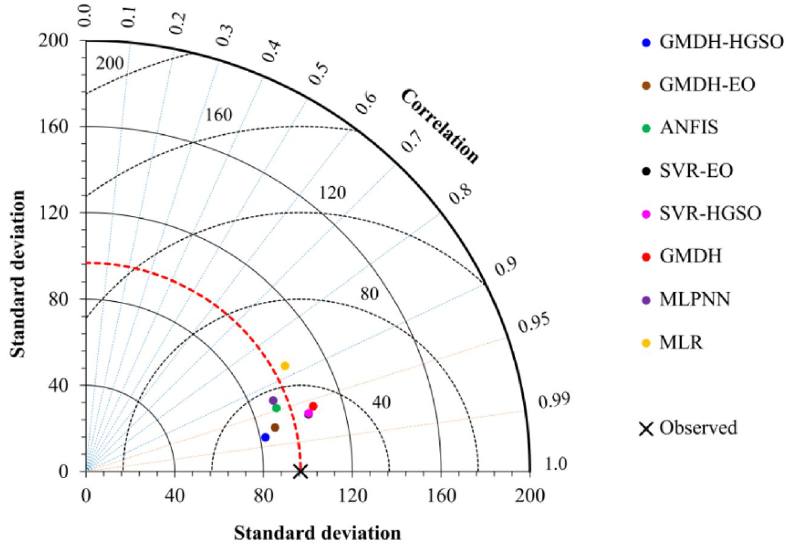
Figure 5. Taylor diagram of the applied models (testing